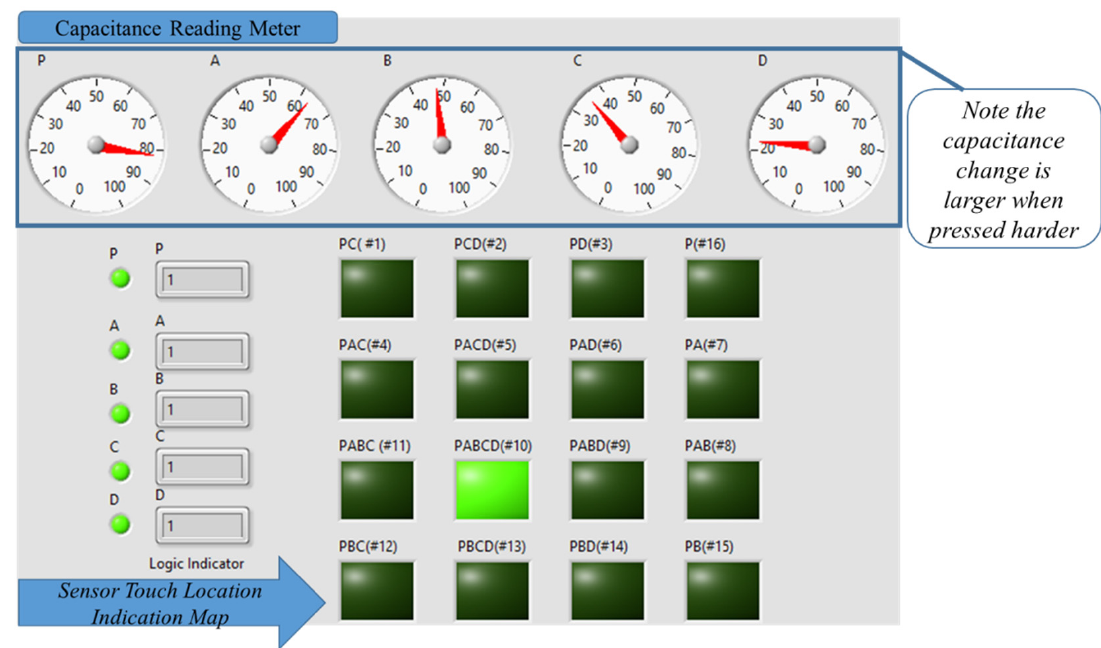
Figure 9. LabVIEW GUI readouts displayed real-time of the multi-functional sensor, when location # 10 pressed with greater